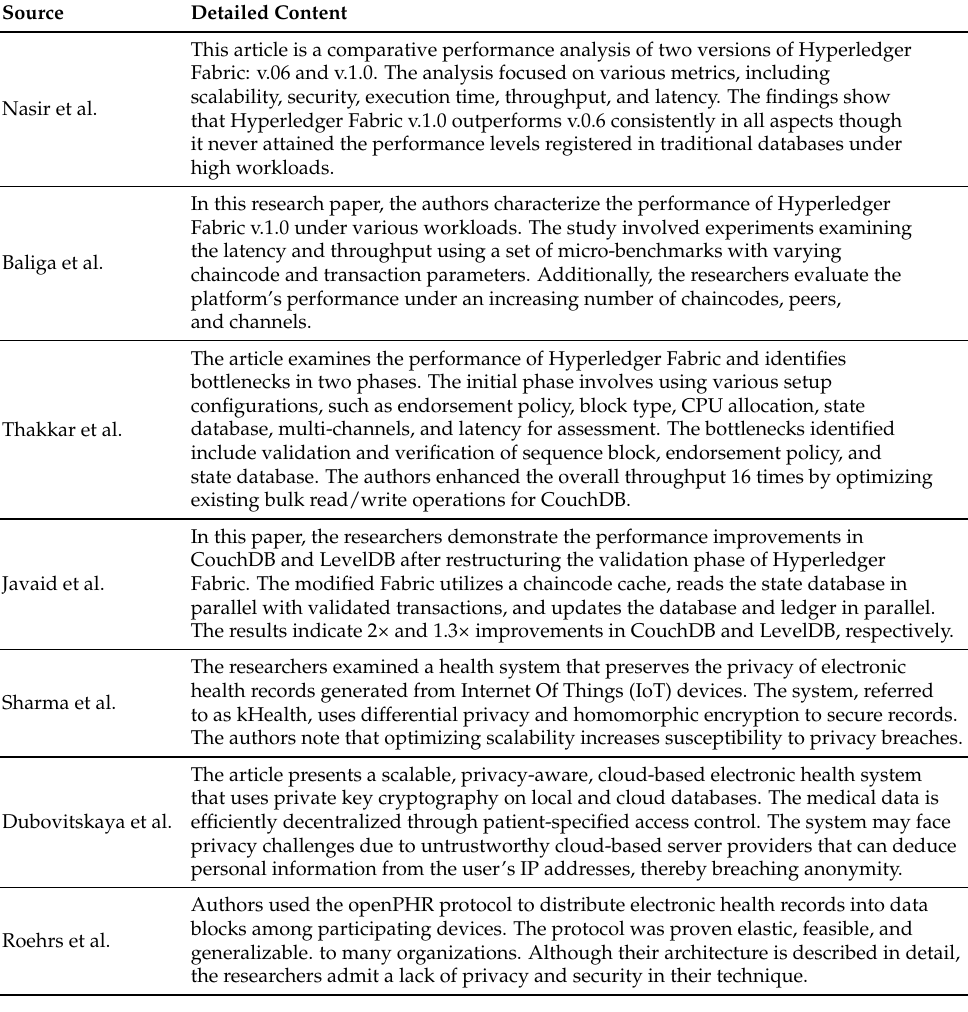
Table 8. Summary of the performance evaluation of Hyperledger